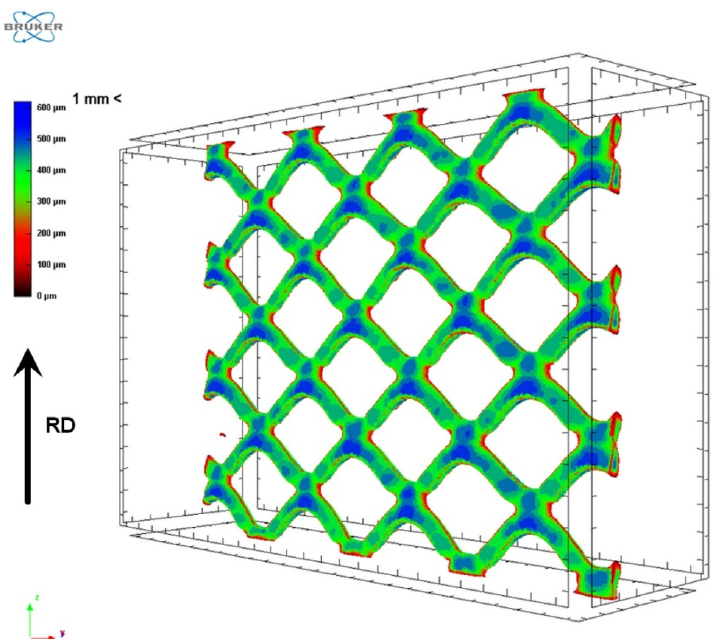
Figure 2. General view of reinforcing mesh inside the roll-bonded composite; RD: rolling direc- tion.